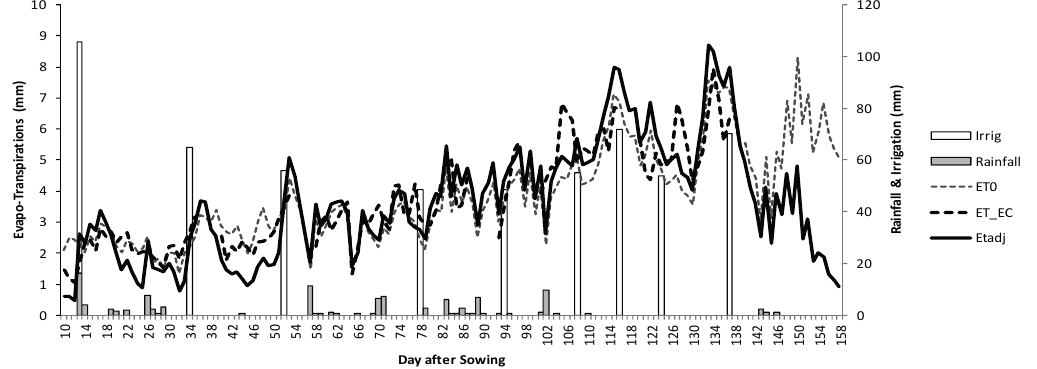
Figure 8. Forcing (ET 0 , Rainfall and Irrigation) of the Water Balance and comparison of measured Evapotranspiration (ET_EC) and Calculated Evapotranspiration (ETadj) for the experimental plot.